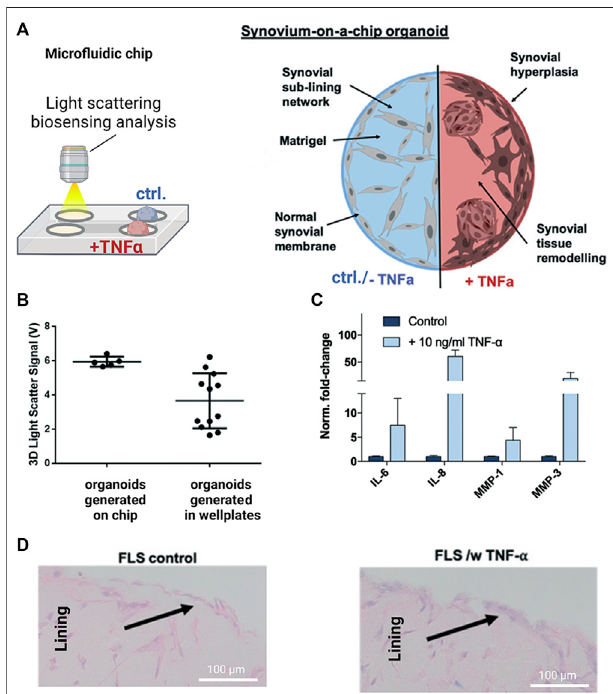
FIGURE 4 | Noninvasive biosensor integration enables structural analysis of synovial on-chip organoids. (A) Light scattering measurements were combined with a human synovium-on-a-chip (top panels) to investigate structural alterations in rheumatoid arthritis (RA). (B) Light scatter analysis of on-chip generated untreated synovial organoids shows higher reproducibility than conventional synovial micromasses generated in microtiterplateswhile (C) retainingtheirabilitytorespondtoTNF- α stimulation with upregulation of interleukins (IL-6/-8) and proteases (MMP-1/-3) (D) Synovial on-chip organoids showed synovial lining hyperplasia upon TNF- α stimulationcharacteristicforRAsynovialintima.Reproducedwithpermissions from (Rothbauer et al.,